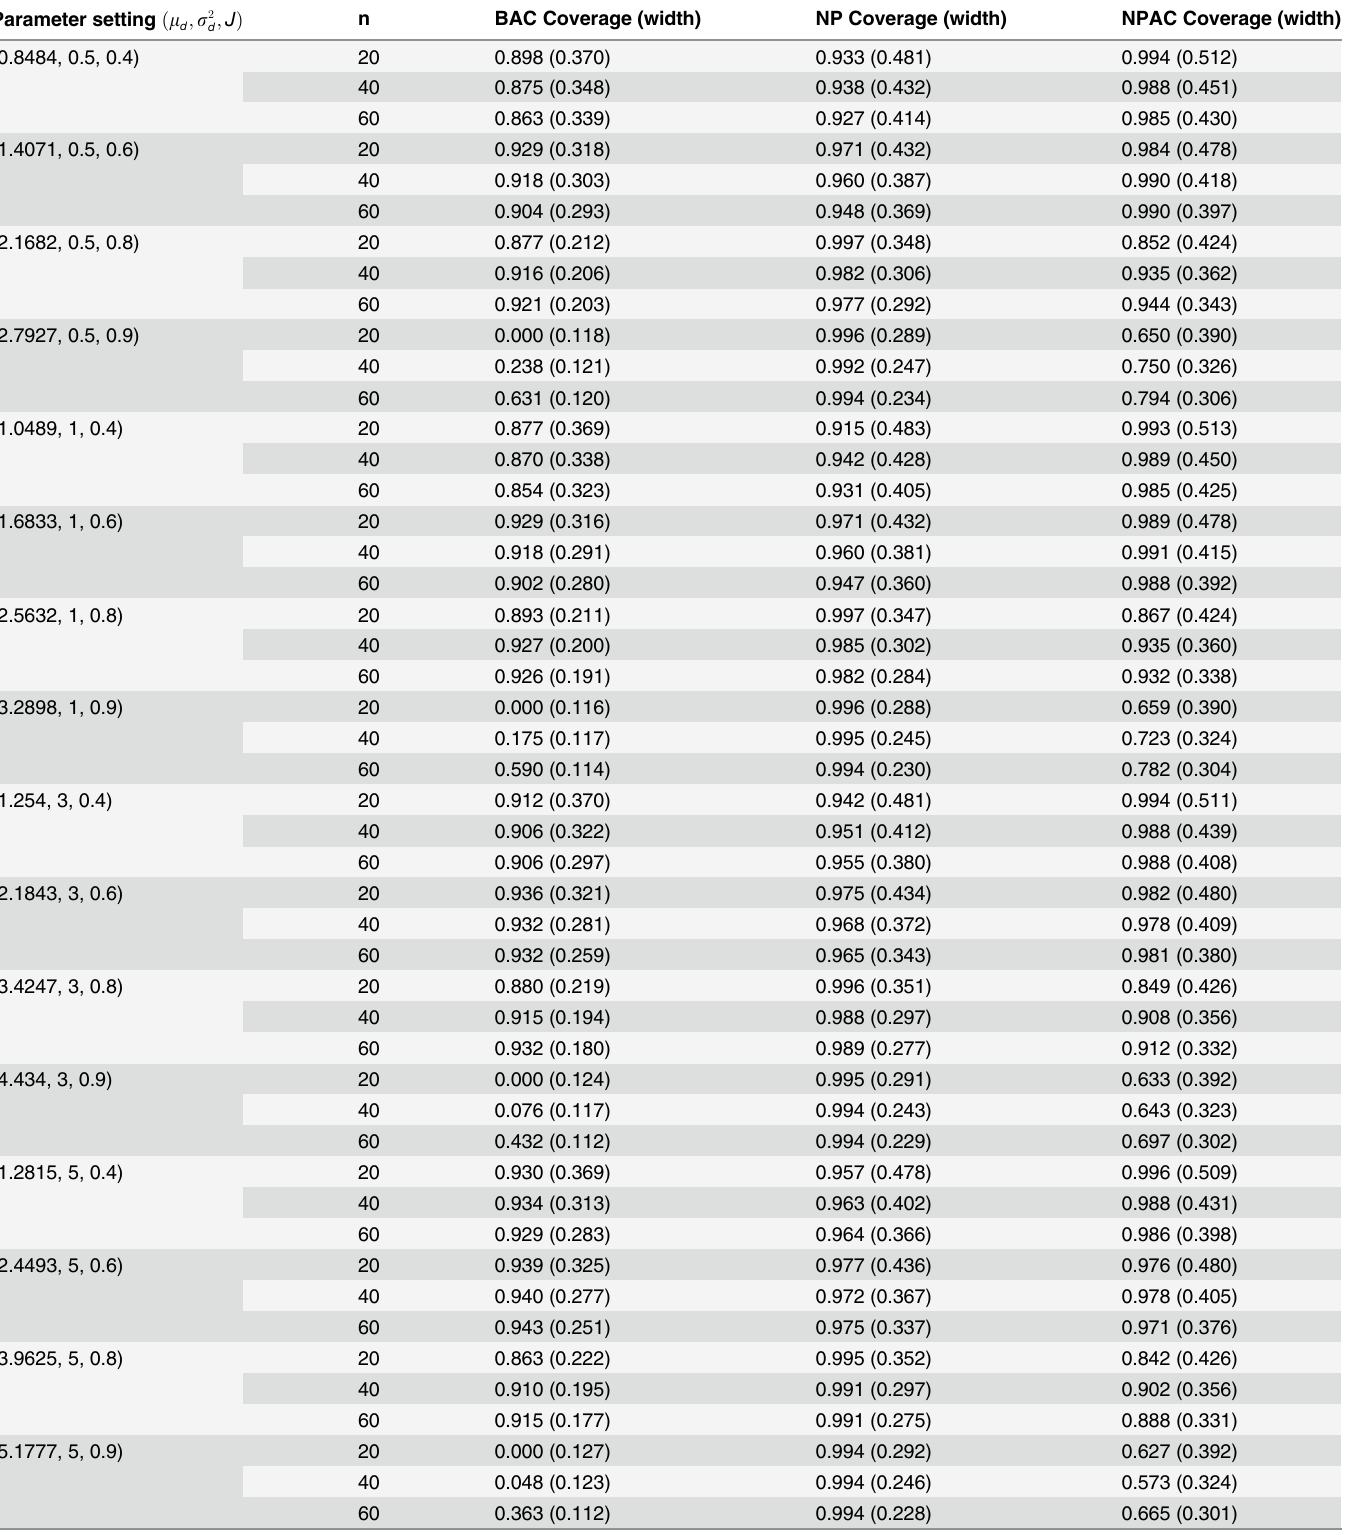
Table 1. Normal distributions: coverage probabilities and average widths when m = 20 in the non-diseased group at the 95% nominal